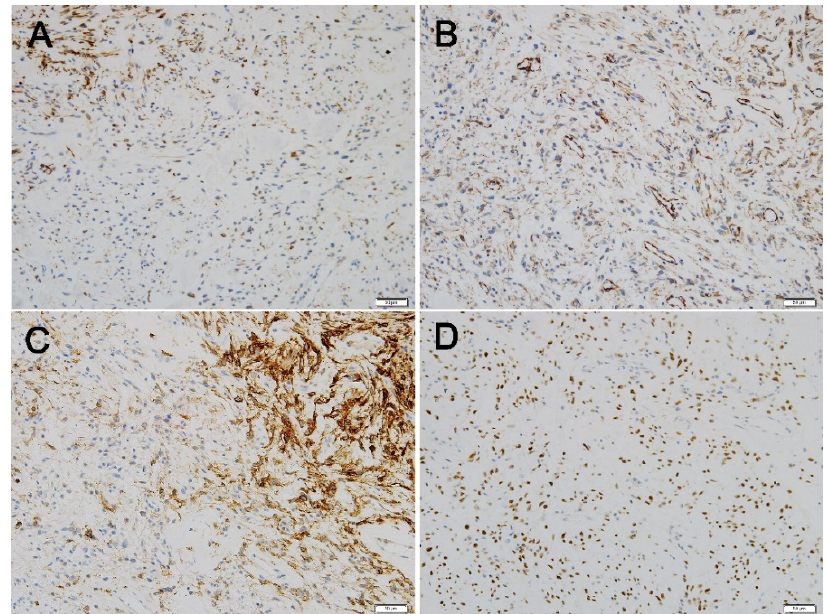
Figure 4. Immunohistochemical staining of the lung mass. ( A ) Desmin is expressed in some tumor cells (200×), ( B ) h-Caldesmon is diffusely positive (200×). ( C ) Tumor cells reveal patchy cytoplasmic immunoreactivity on CD10 (200×). ( D ) Diffuse nuclear positivity of tumor cells with WT1 (200×).